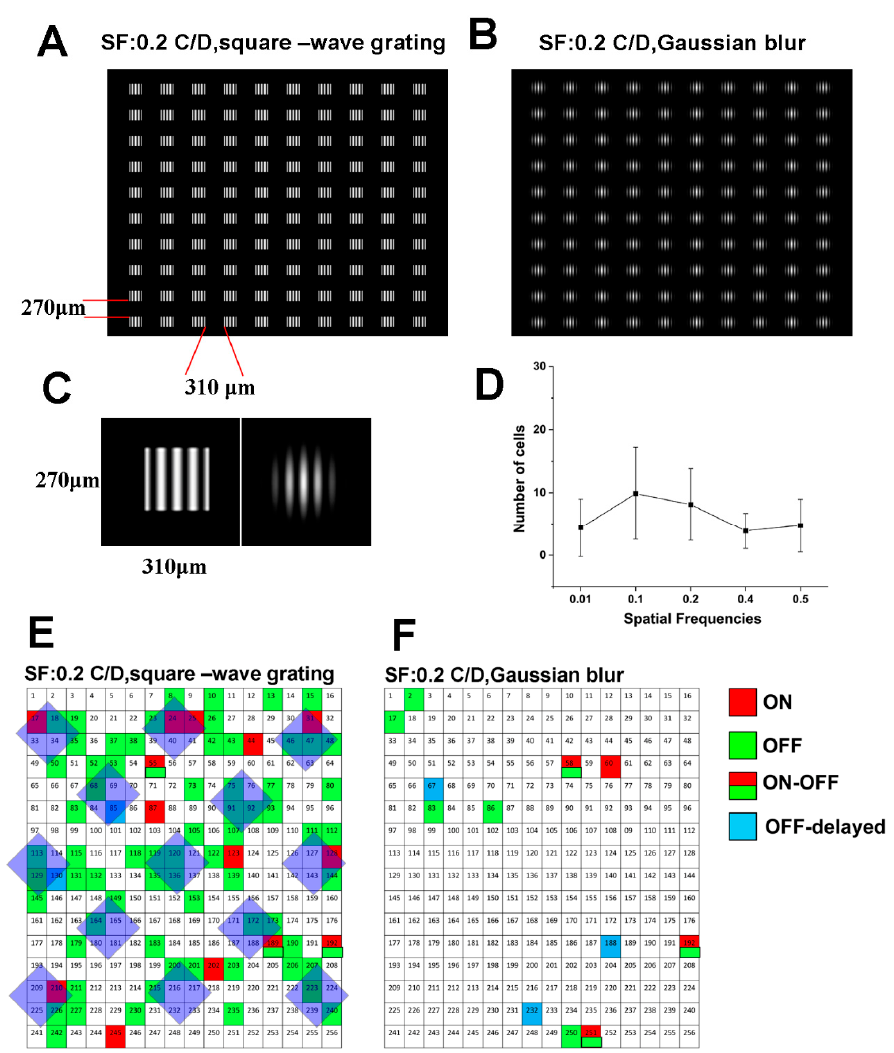
Figure 3. Maps of firing patterns after clear and blurred images were projected on the mouse retina: 10 × 10 image arrays with 270 µm × 310 µm spatial frequency 0.2 cycle/degree (C/D) ( A,C ) clear image, square-wave grating and 0.2 C/D ( B,C ) blurred image, Gaussian blur were programmed to project on the mouse retina. ( D ) Cells had maximal responses to 0.2 cycle/degree, square-wave grating with MEA recording. ( E ) Firing patterns of different RGCs/ACs can reflect the image projected for clear images (focused). ( F ) Projection of blurred images could not reflect in the mouse retina. Light intensity: 8.6 × 10 4 Rh*/rod/sec in 0.2 C/D, square-wave grating to 6.1 × 10 4 Rh*/rod/sec in 0.2 C/D, Gaussian blur. Light stimulus time was 1 s, at 5 s interval and recorded for 60 min. 2.3. Dopamine Effects on RGC/AC Firing Pattern Responses to Focused and Defocused Images on MEA Recording Dopamine acts as an important neurotransmitter in the retina and mediates retinal development,